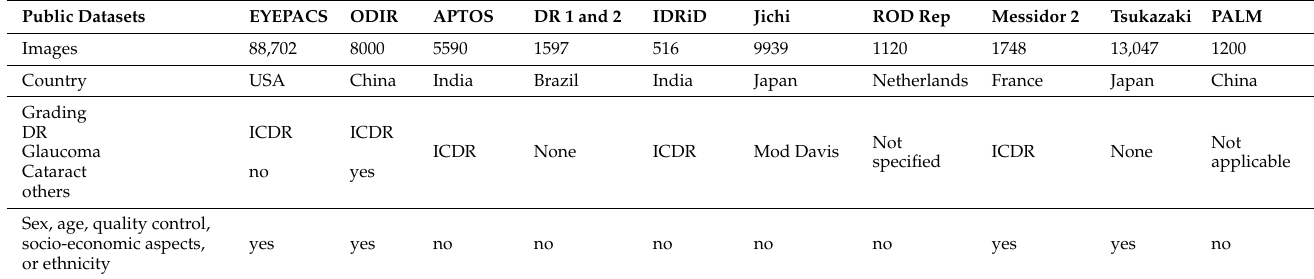
Table 2. The open-access public ophthalmological datasets of retinal photographs used in a number of countries. International Clinical Diabetic Retinopathy